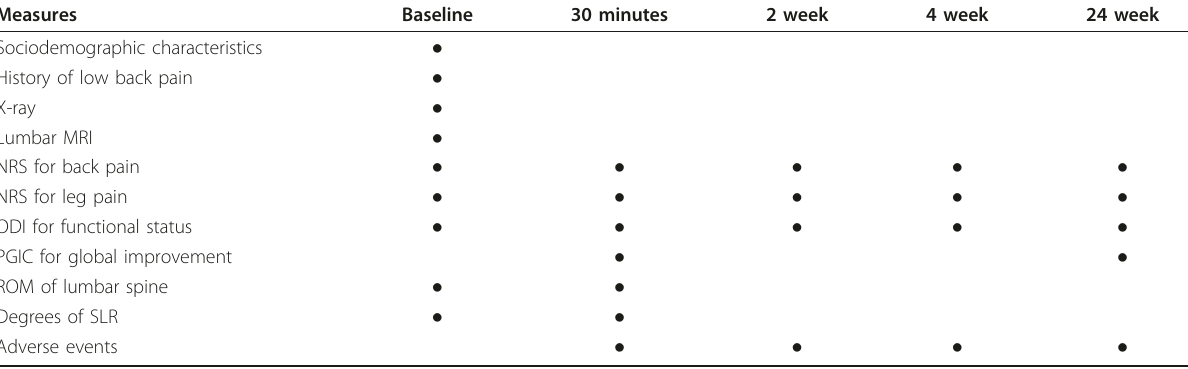
Table 1 Schedule for data collection and outcome